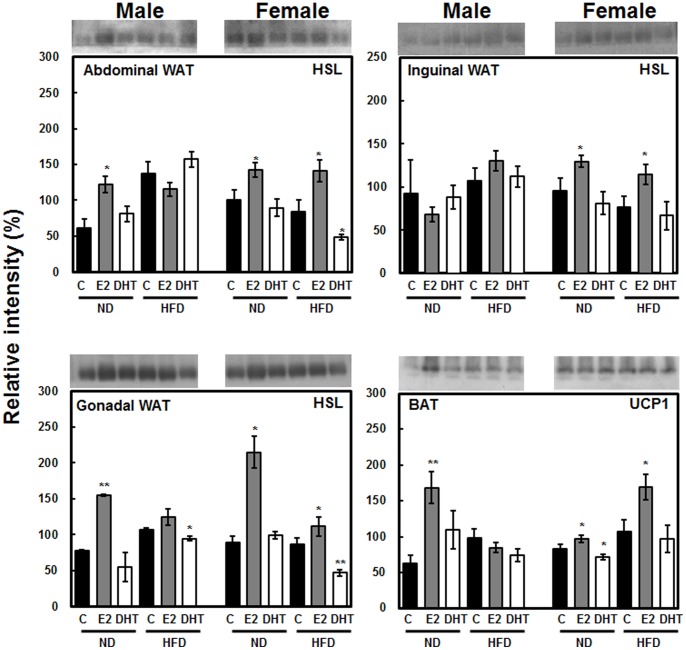
Differential expression of hormone sensitive lipase (HSL) in WAT and uncoupling protein 1 (UCP1) in BAT before and after treatments with high fat diet and sex steroid hormones in both sexes.Band densities were normalized using β-actin in each tissue to calculate relative intensity (%). Statistical significance between control and hormone treated groups were calculated by Student’s t-test, where, *p<0.05 and **p<0.01. The significance of the effects of sex, diet and hormonal treatments was tested using multivariate ANOVA (M-ANOVA), where p<0.05.